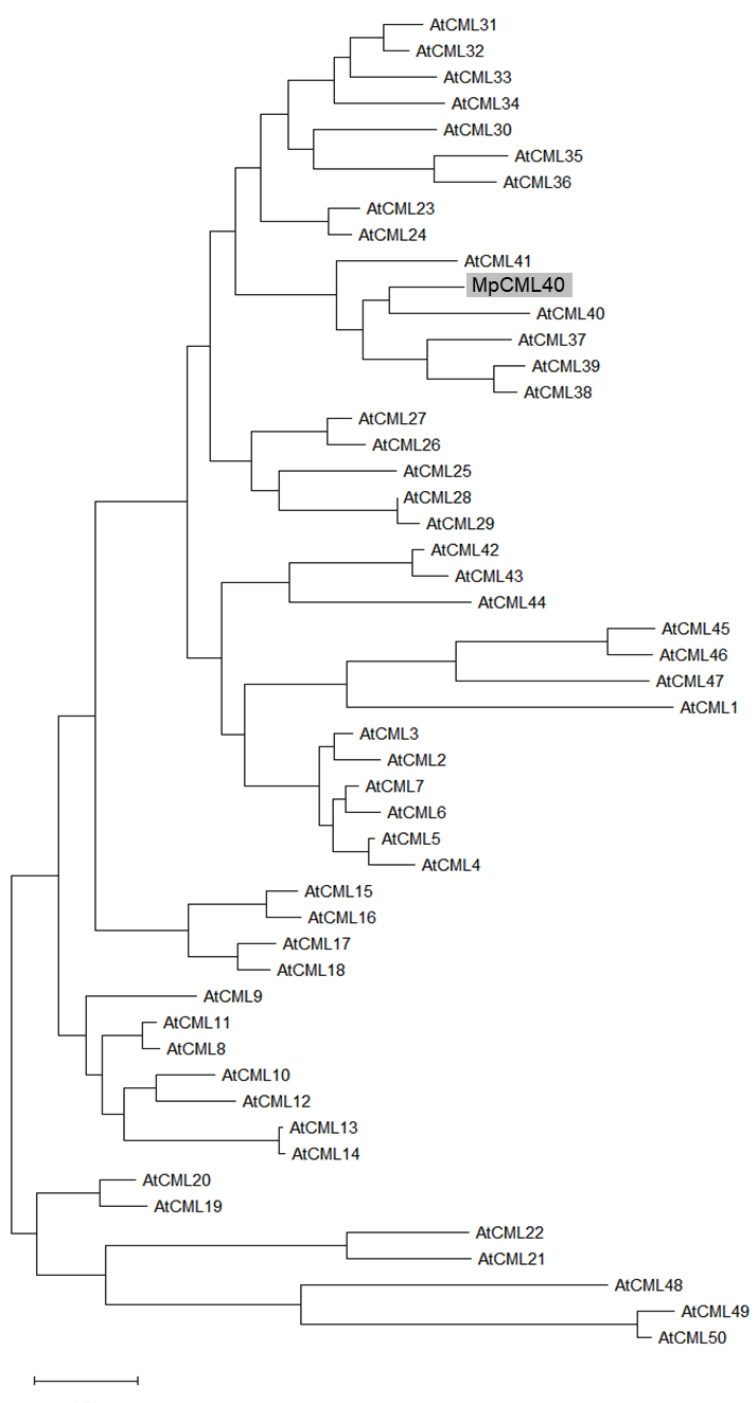
Figure 1. Phylogenetic tree of MpCML40 with Arabidopsis CML proteins. MpCML40 protein and 50 Arabidopsis calmodulin-like (CML) proteins were used for phylogenetic analysis [22]. MpCML40 was marked by a grey box.